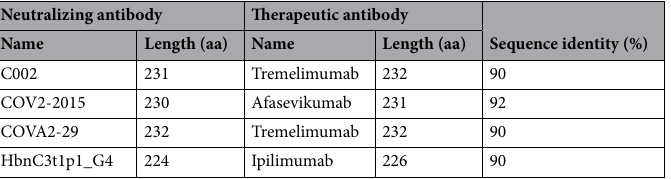
Table 2. Final list of screened SARS-CoV-2 specific neutralizing and therapeutic